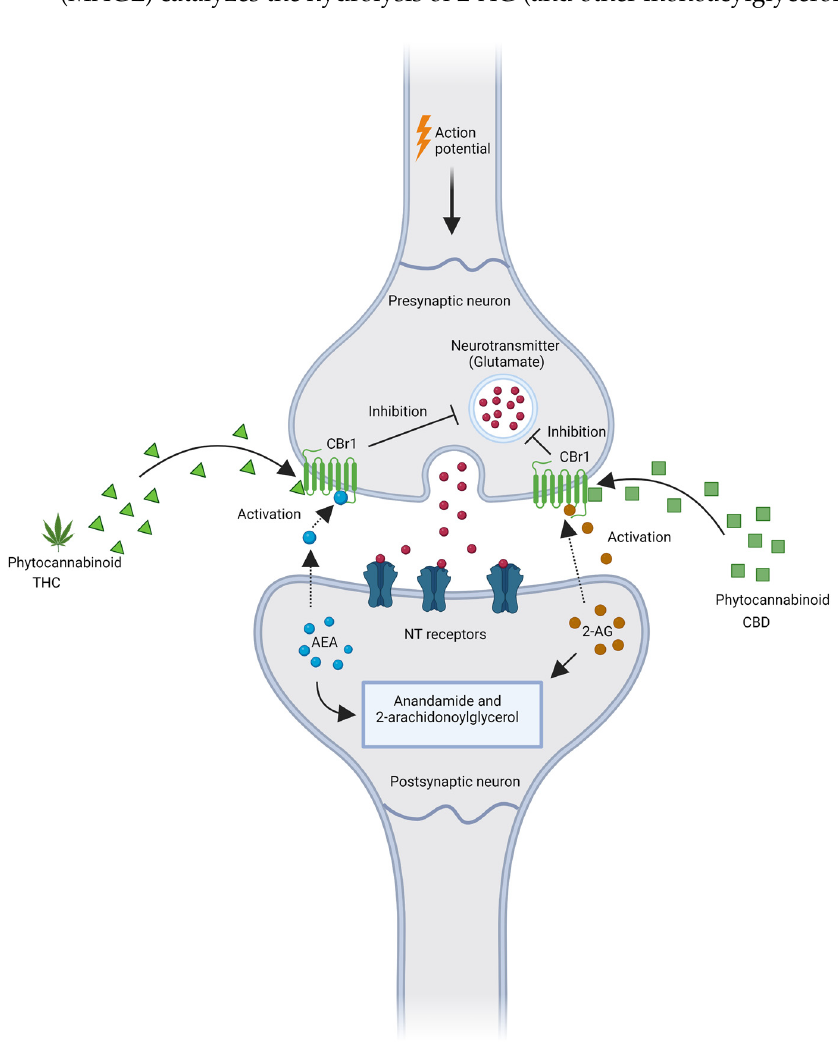
Figure 1. Simplified scheme of the basic modulation of the endocannabinoid system by phytocannabinoids (CBD and THC). The main mechanism by which endocannabinoids regulate synaptic function is retrograde signaling [37]. Once released from the postsynaptic neuron, endocannabinoids bind to CBr1 located on the presynaptic membrane to inhibit the release of neurotransmitters. Endocannabinoids are removed from the synaptic junction after CBr1 activation via cellular transport followed by hydrolysis. AEA is hydrolyzed in postsynaptic neurons by fatty acid amide hydrolase (FAAH), terminating its action. After CBr1 activation, 2-AG is hydrolyzed in presynaptic neurons by monoacylglycerol lipase (MAGL). This retrograde signaling provides an inhibitory feedback mechanism to regulate neurotransmitter release in the brain. [38,39]. NT- neurotransmitter receptor. Created with BioRender.com, accessed on 28 November